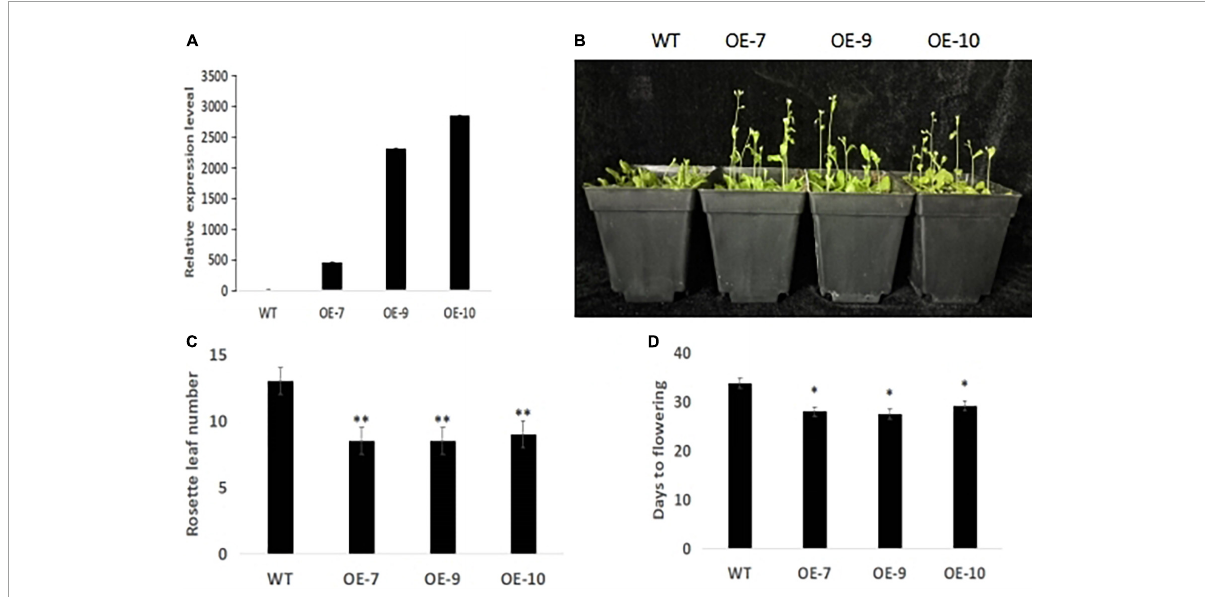
FIGURE6 SiCOL5 positively regulates flowering time in Arabidopsis . (A) Identification of SiCOL5 overexpression plants by qRT-PCR. (B–D) Phenotype (B) , rosette leaf number (C) , and days to flowering (D) of SiCOL5 overexpression plants compared with wild-type plants. ** p < 0.01, * p < 0.05.